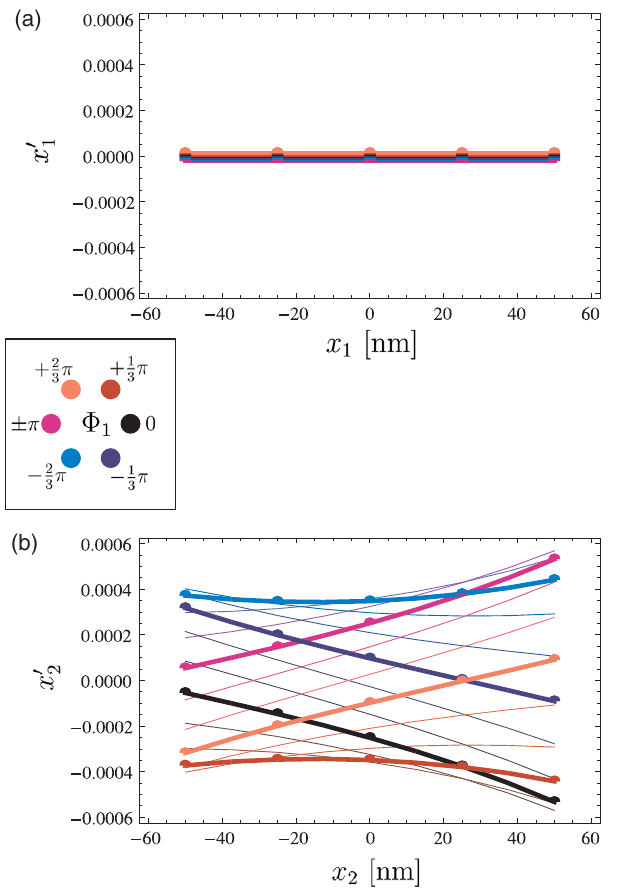
FIG. 4. The properties of the transfer function for the unit cell shown in Fig. 3. (a) Assumed ð x 1 ; x 0 1 Þ at the entrance of the cell. (b) Calculated ð x 2 ; x 0 2 Þ at the exit of the cell. The result depends on the initial phase Φ 1 (color coded). The thicker lines corre- spond to six selected phases: − π ; − 2